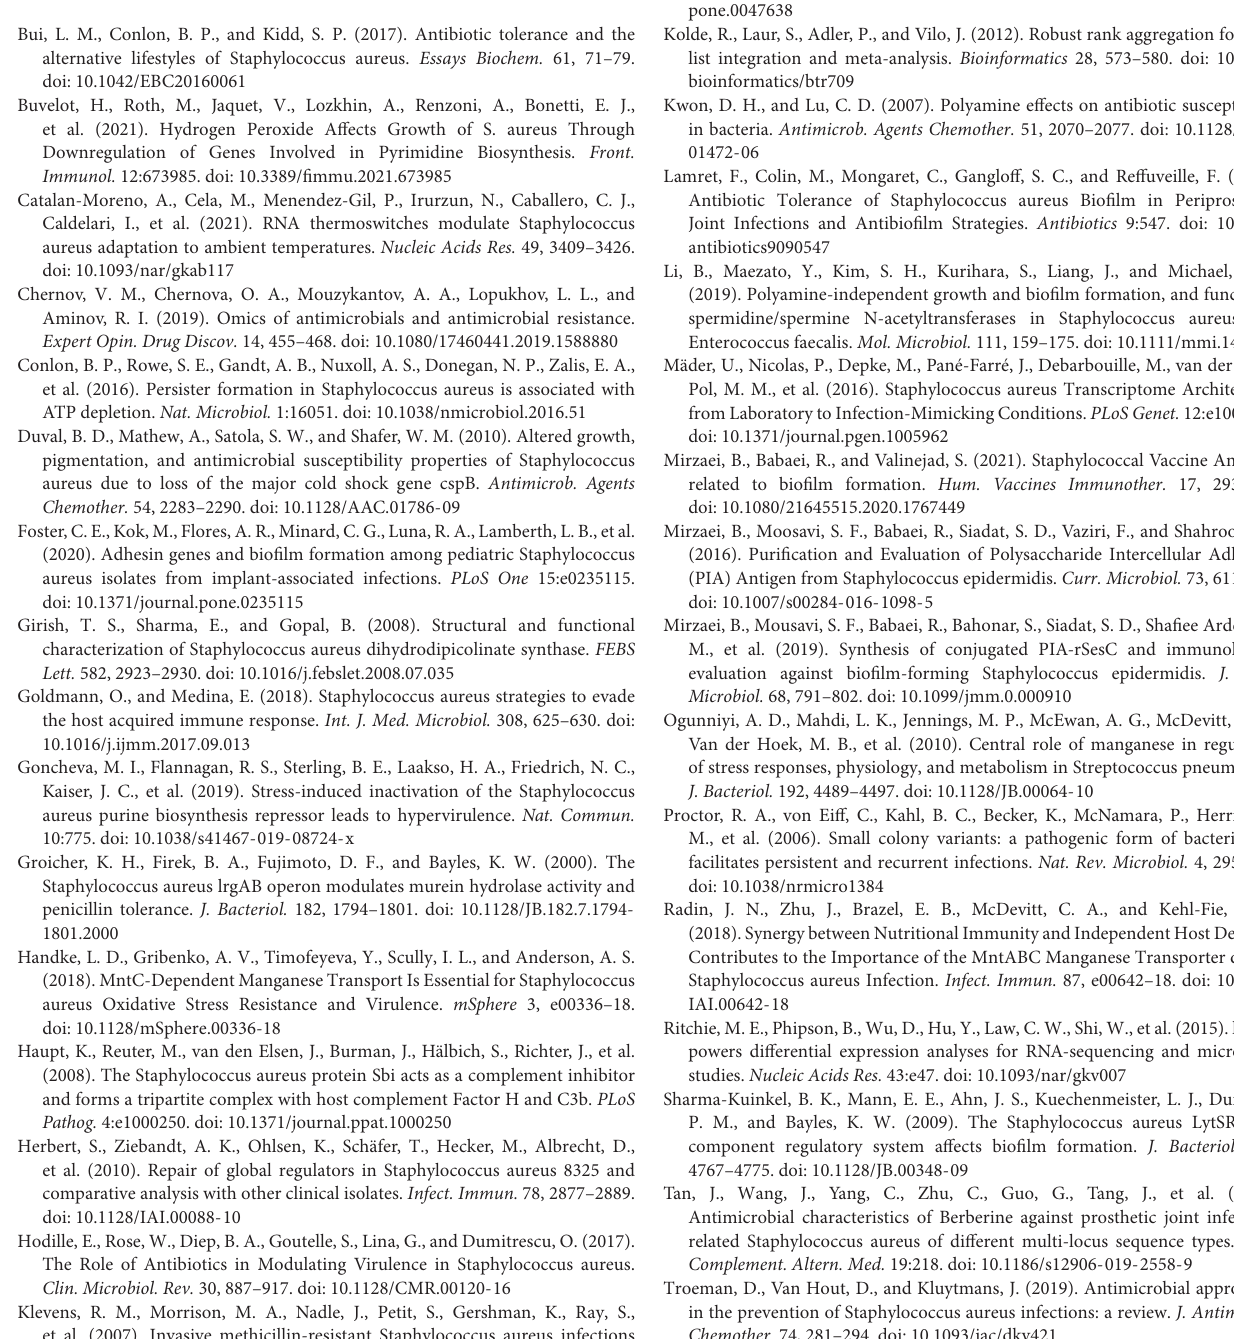
Supplementary Figure 2 | PCR verification of the qPCR primer product size and primer efficiency. Supplementary Figure 3 | Standardization of gene expression GSE70043.